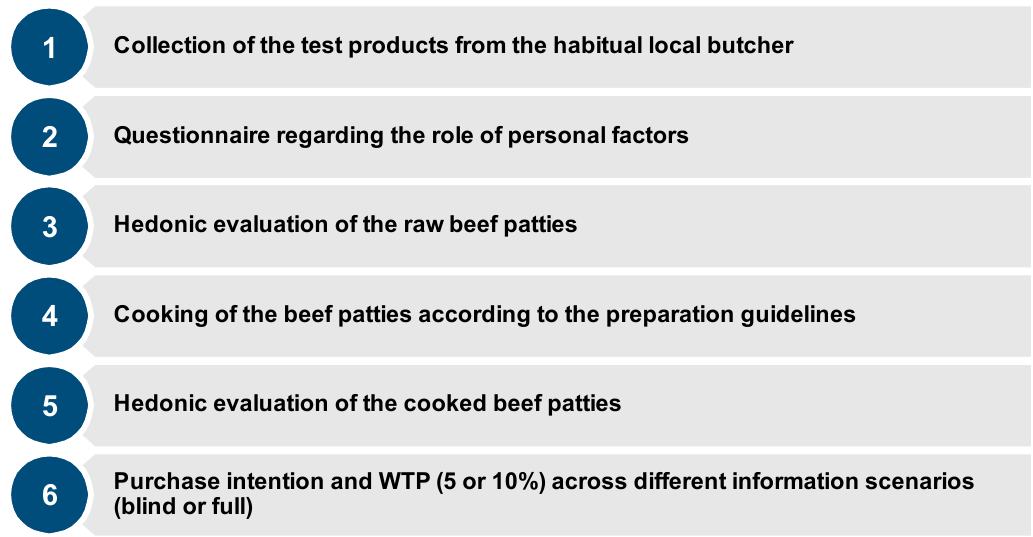
Figure 2. Procedure followed by consumers at the in ‐ home use test.